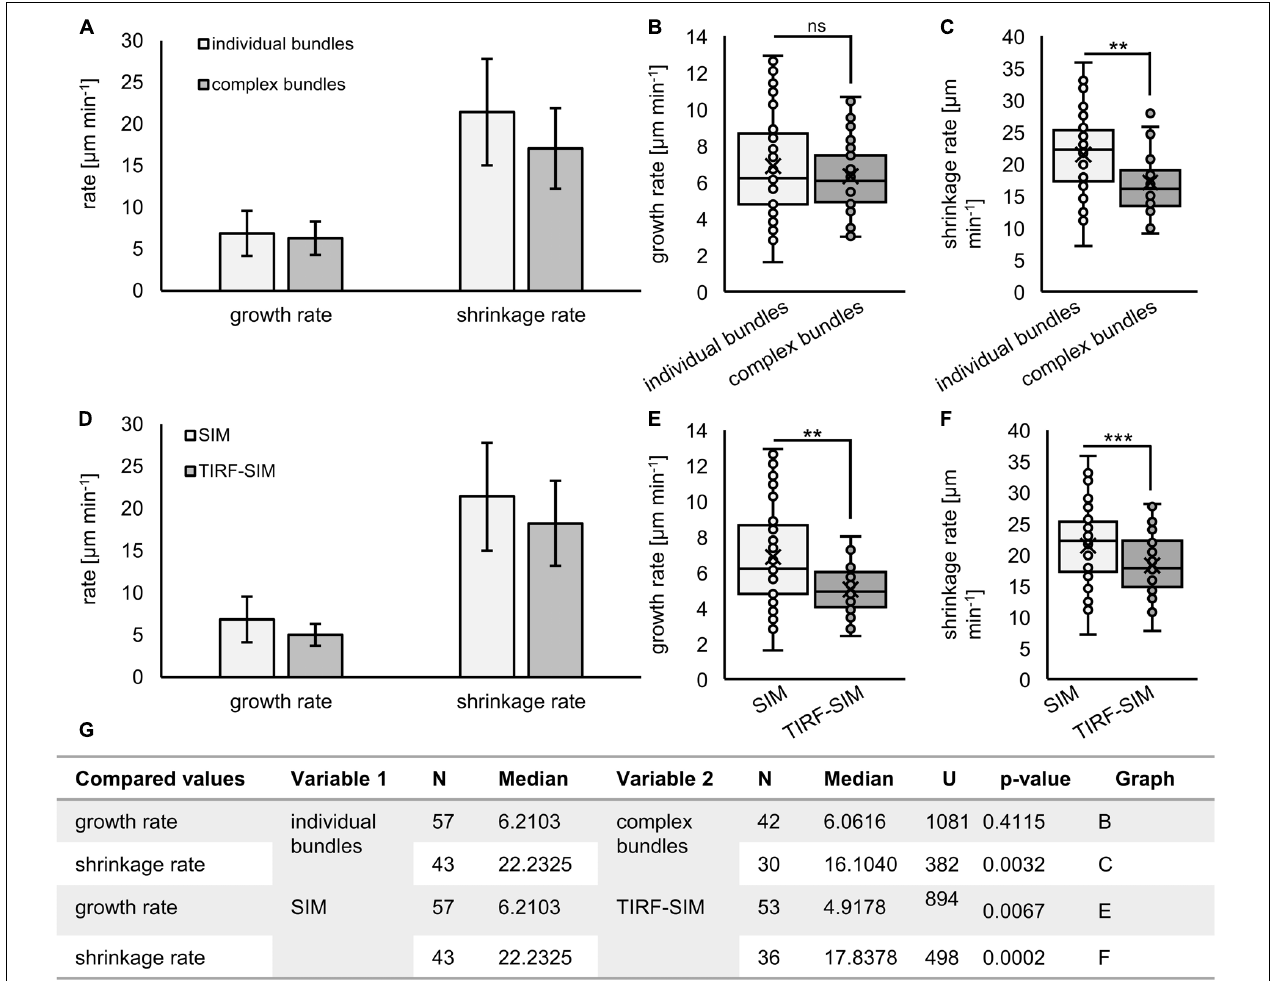
FIGURE 10 | Quantification of MAP65-2 dynamics. Kymographs were generated from videos of stably transformed line expressing eGFP-MAP65-2 made by either 2D SIM (objective 63 × /1.40 NA) or TIRF-SIM (objective 100 × /1.49 NA). The kymographs were measured and growth and shrinkage rates were calculated (as described in section “Materials and Methods”). (A–C) Comparison of growth (A,B) and shrinkage (A,C) rates for individual and complex bundles observed on 2D SIM. (D–F) Comparison of growth (D,E) and shrinkage (D,F) rates for bundles imaged by either 2D SIM or TIRF-SIM. In (A,D) , means and standard deviations are shown. In (B,C,E,F) , results from statistical analysis are shown, for which was used Mann–Whitney U test (*** significant at p 0.001, ** significant at p 0.01, ns, not statistically significant) and the results of statistical analysis are in (G) , where U is the result of Mann–Whitney test. Description of box plot: average is presented by × , median by the middle line, 1st quartile by the bottom line, 3rd quartile by the top line; the whiskers lie within the 1.5 × interquartile range (defined from the 1st to the 3rd quartile), outliers are presented by